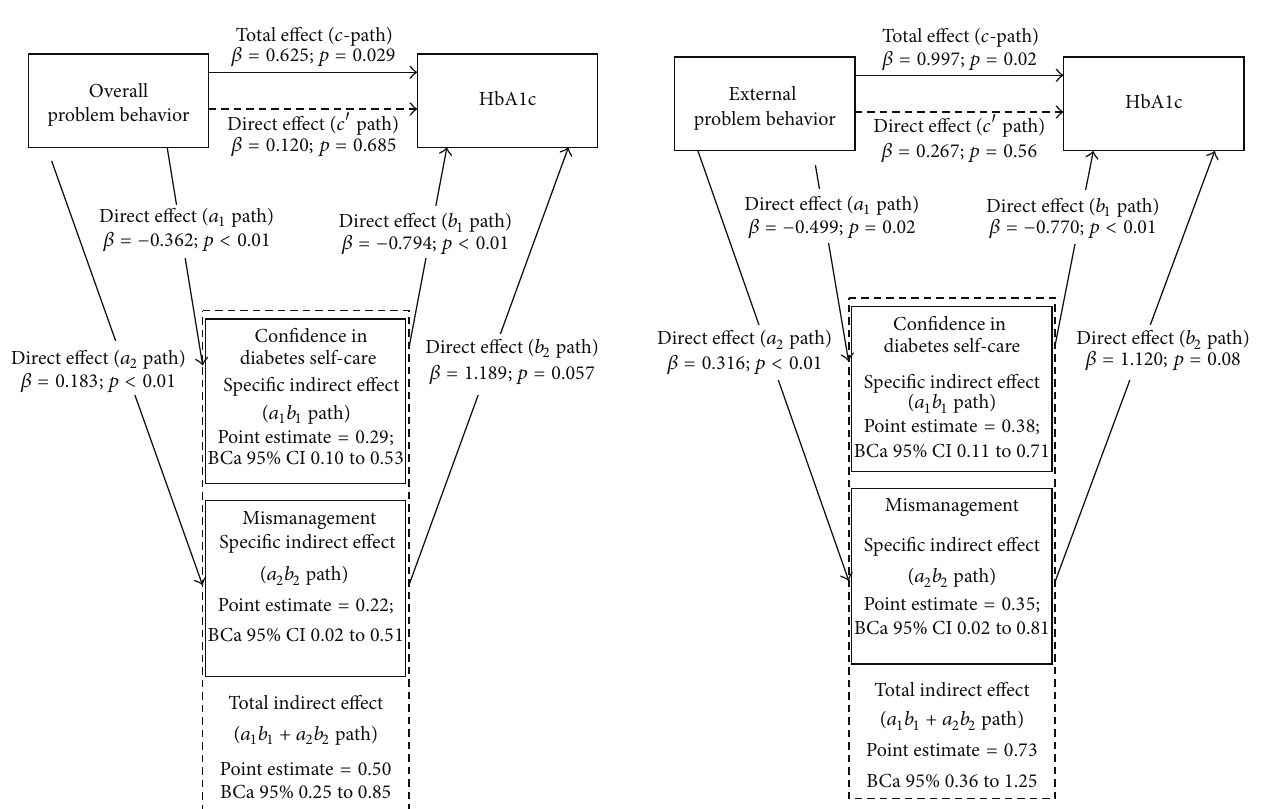
Figure 1: Graphic representation of the multiple mediation model of the associations between overall problem behavior and glycemic control with confidence in diabetes self-care and mismanagement of diabetes self-care. 5000 resamples were calculated while using the bootstrap method [24].